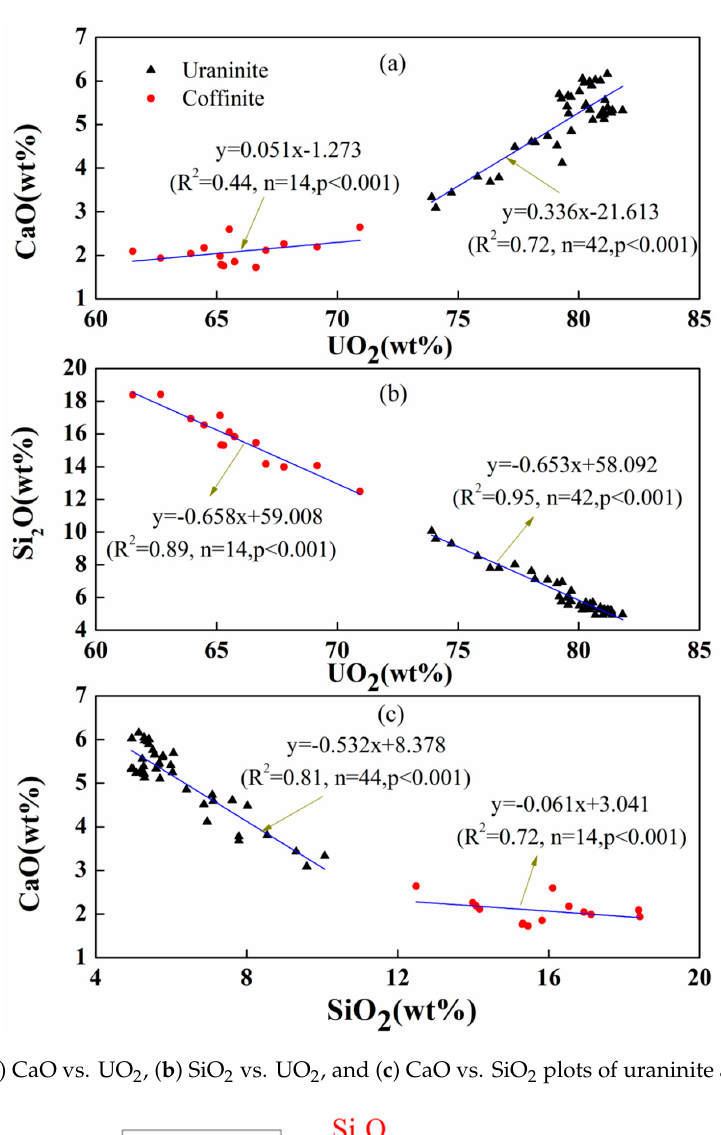
Figure 10. ( a ) CaO vs. UO 2 , ( b ) SiO 2 vs. UO 2 , and ( c ) CaO vs. SiO 2 plots of uraninite and coffinite.